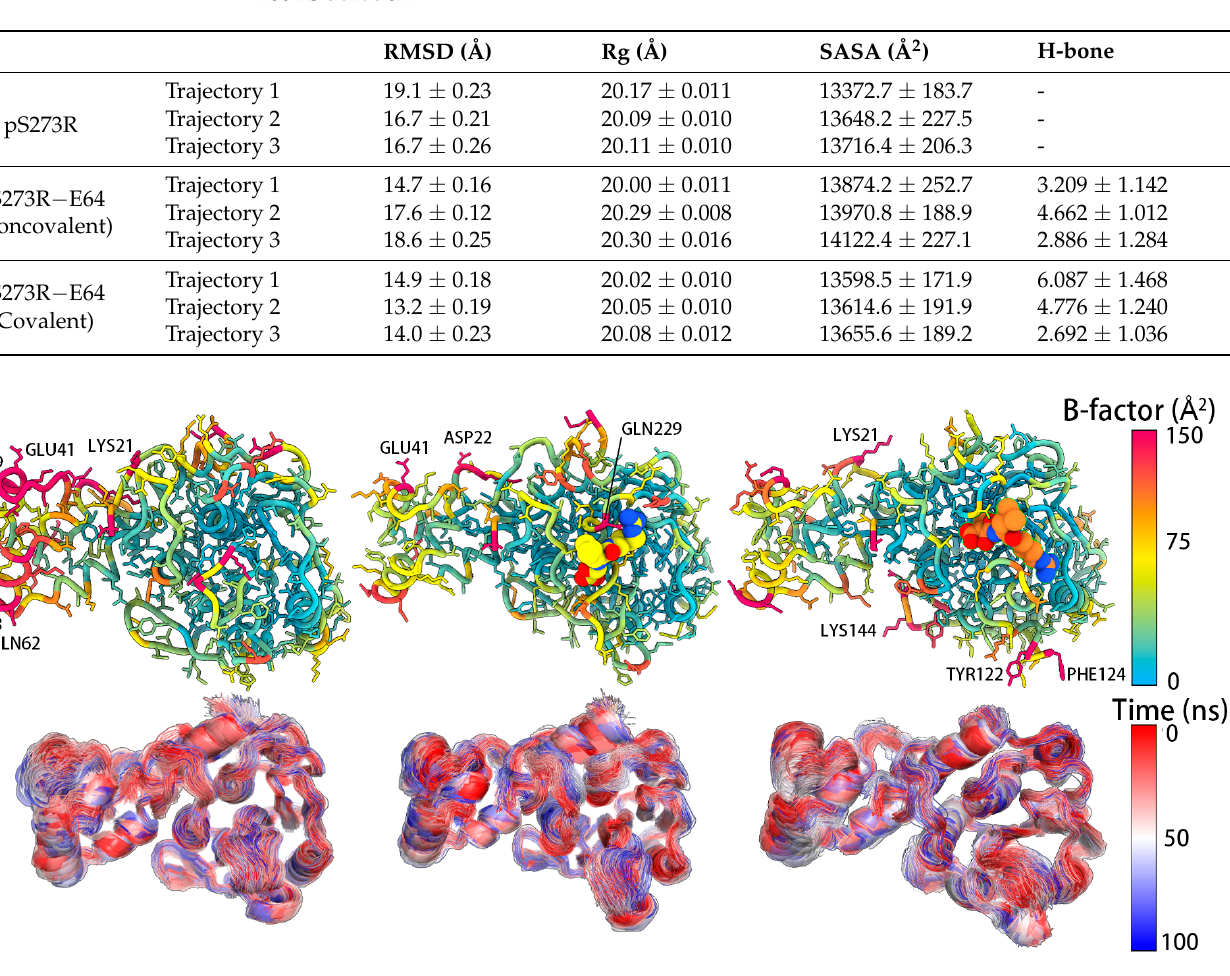
Figure 5. B-factor (Transformed by RMSF) and motion trajectories of pS273R − E64 complexes and pS273R. ( A ) B-factor mapped using chimera X for pS273R of free state and covalent and noncovalent pS273R − E64 complexes. ( B ) Trajectories for pS273R of free state and covalent and noncovalent pS273R − E64 complexes (merged trajectories).